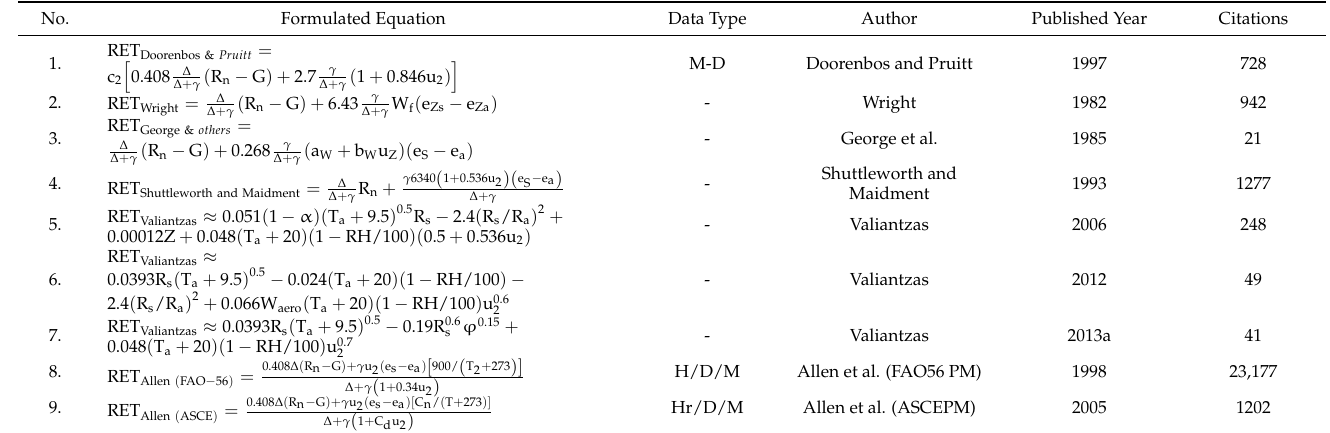
Table A6. RET combination-based